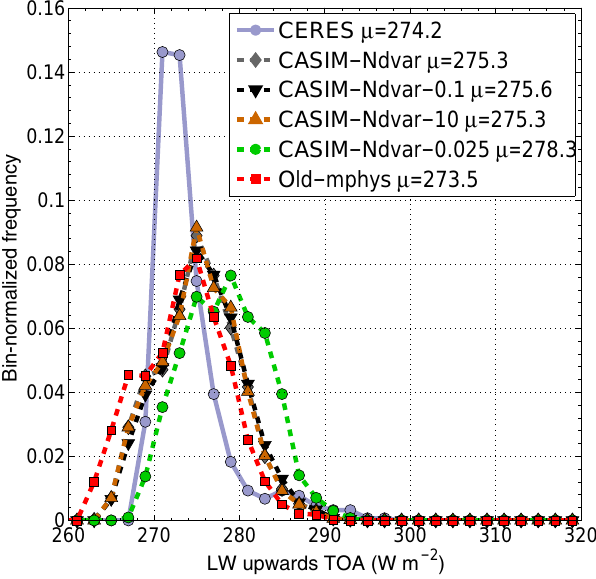
Figure 12. As for Fig. 11, except for nighttime periods and for long- wave only. The times used for CERES are 22:35LST (03:23UTC) on 12 November (Terra satellite), 02:39LST (07:27UTC) on 12 November (Aqua satellite), and 01:44amLST (06:32UTC) on 13 November (Aqua). For the model, the three closest avail- able times were used: 03:30 and 07:30 UTC on 12 November; 06:30UTC on 13